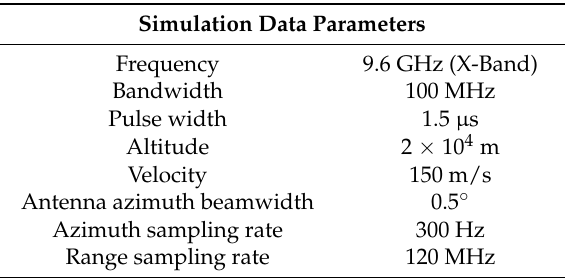
Table 1. System parameters used in the simulation dataset.